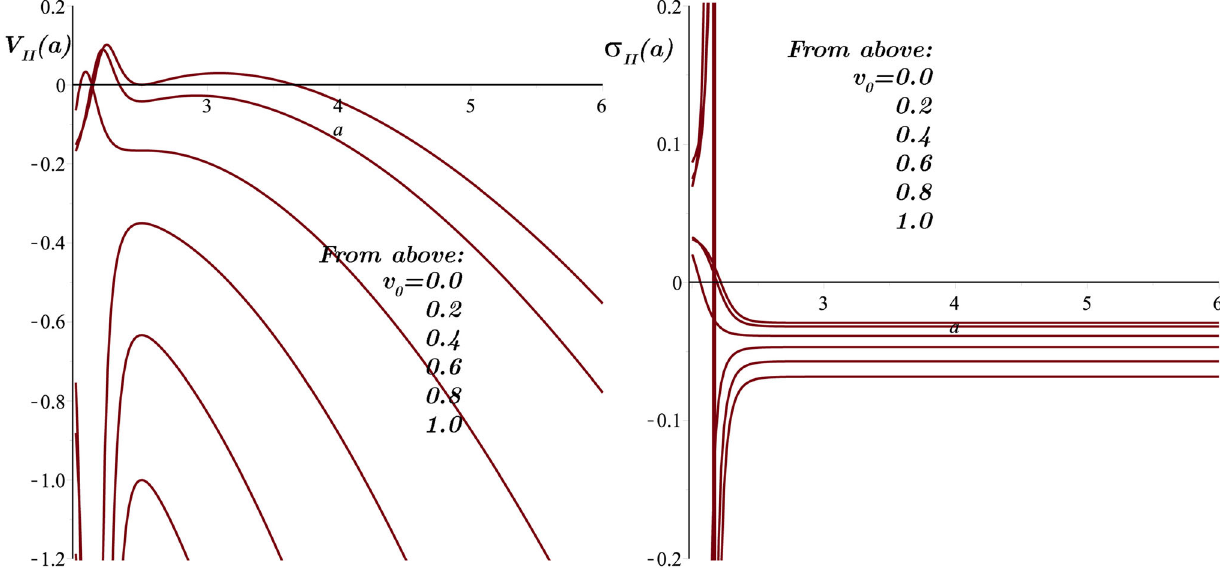
Fig. 3 Plots of V I and σ I against a for a 0 = 5 M , β 2 nonlinear analysis reveals that the well stable STSW in the framework of the linear perturbation, becomes unstable with large enough v 0